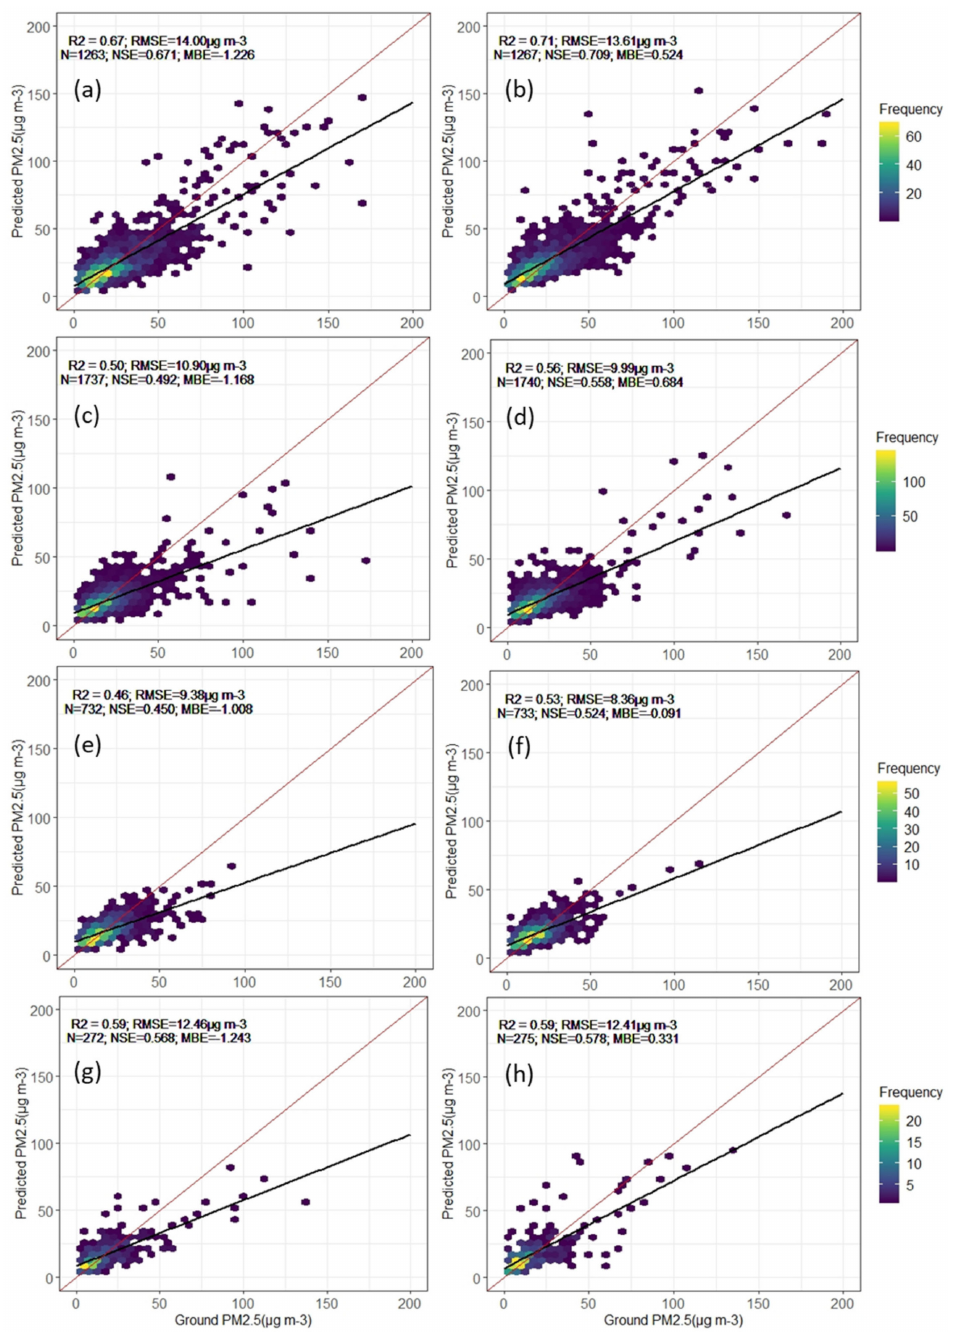
Figure 5. Validation of the predicted PM 2.5 concentrations against measured PM 2.5 using SVR (left) and RF (right) models in dry season (June–September) ( a , b ), wet season (November–March) ( c , d ), inter-monsoon (April–May) ( e , f ) and inter-monsoon (October) ( g , h ). Frequency indicates the density of data/count. The statistical indicators are presented as averaged values in each